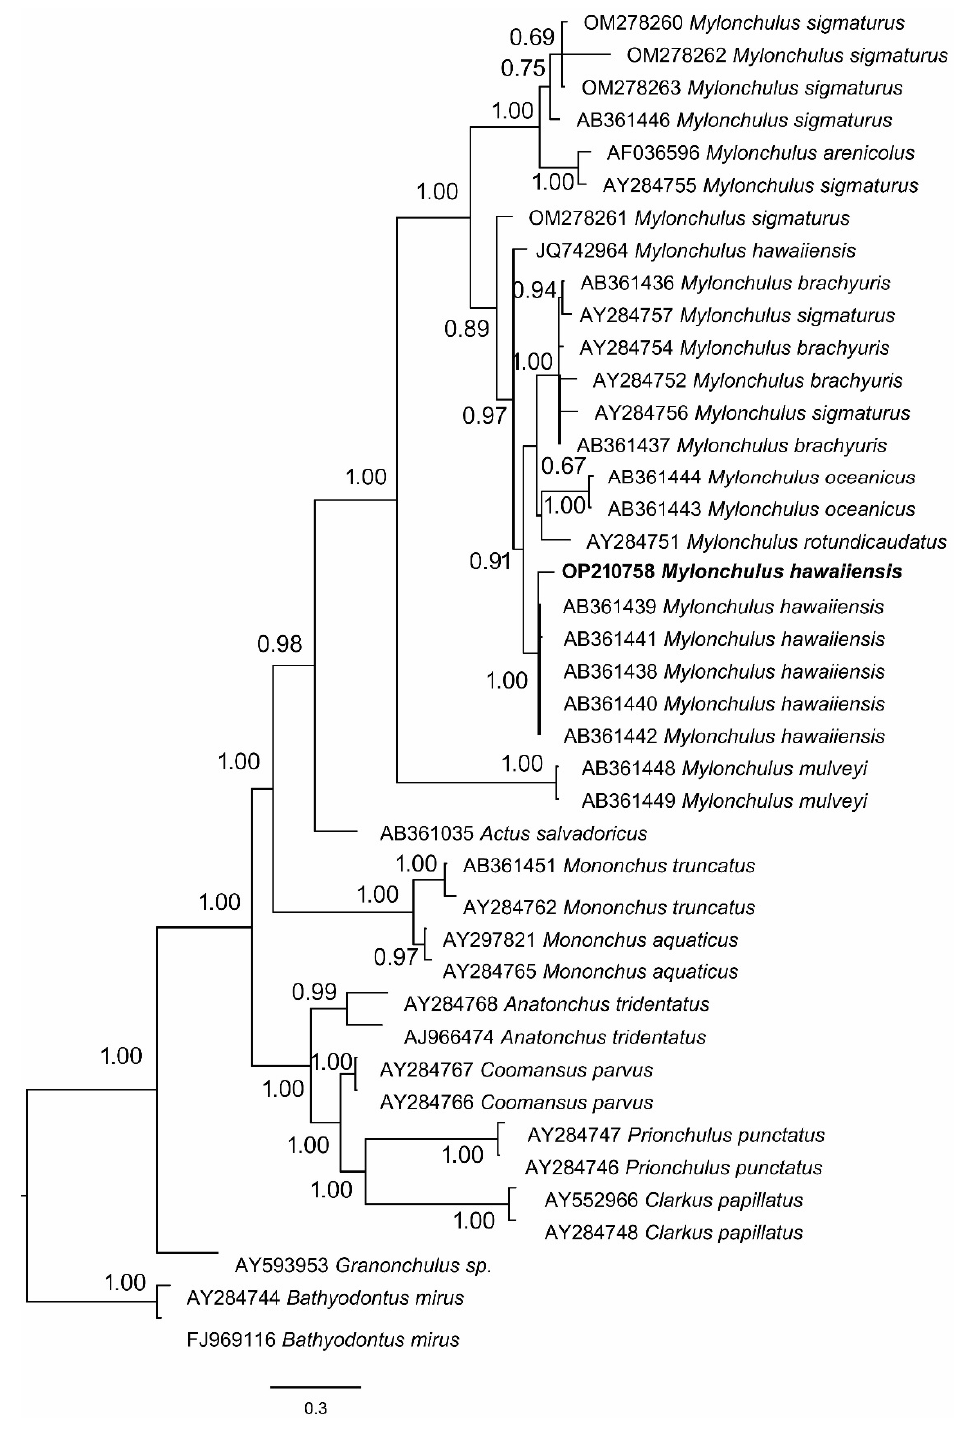
Figure 2. Phylogenetic tree using Bayesian inference, including the newly sequenced M. hawaiiensis based on 18S rDNA.